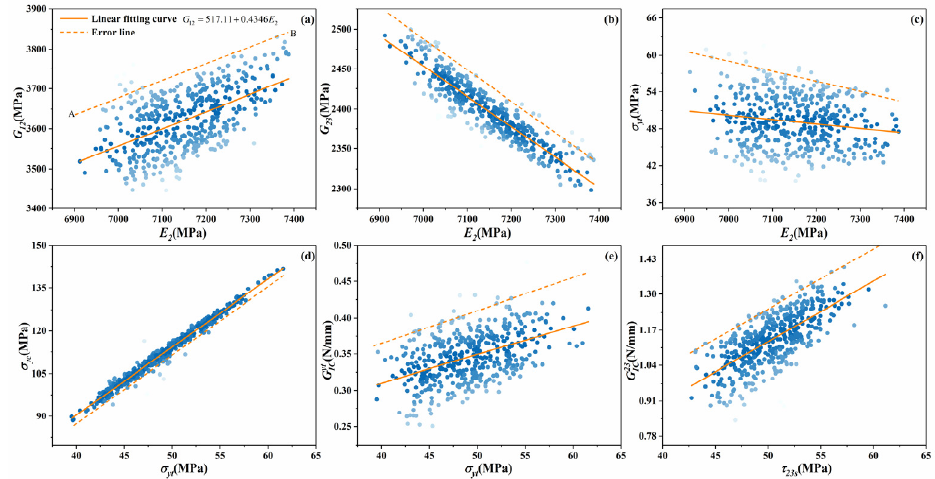
Figure 10. Relationships between the mechanical properties of microscale model with 3% void content.